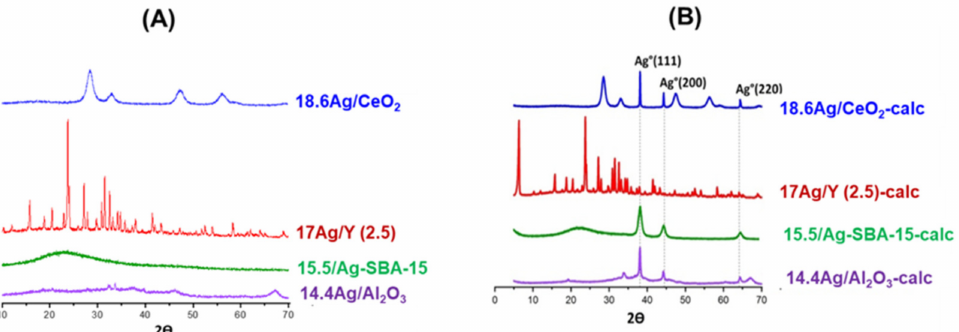
Figure 1. X-ray diffractograms of the silver-impregnated adsorbents: ( A ) samples dried at 80 ◦ C, ( B ) samples calcined at 500 ◦ C (1